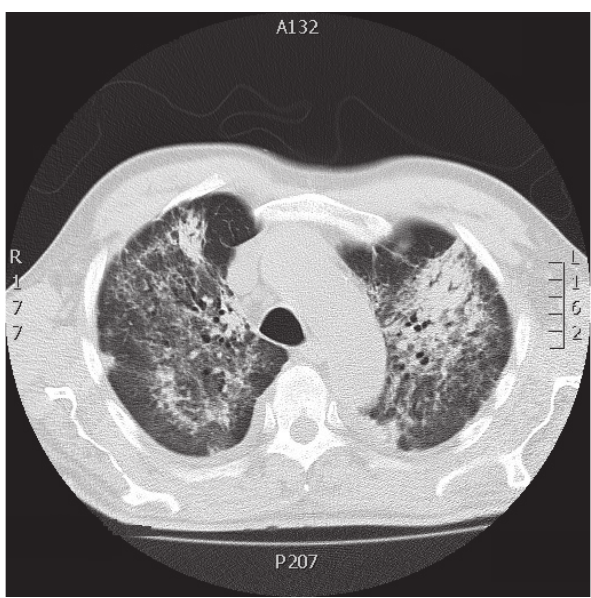
Fig. 2. CT scan of 75-year.old patient with ANCA positive microscopic polyangiitis shows extensive bilateral pulmonary inflammatory infiltrates, resulting in respiratory